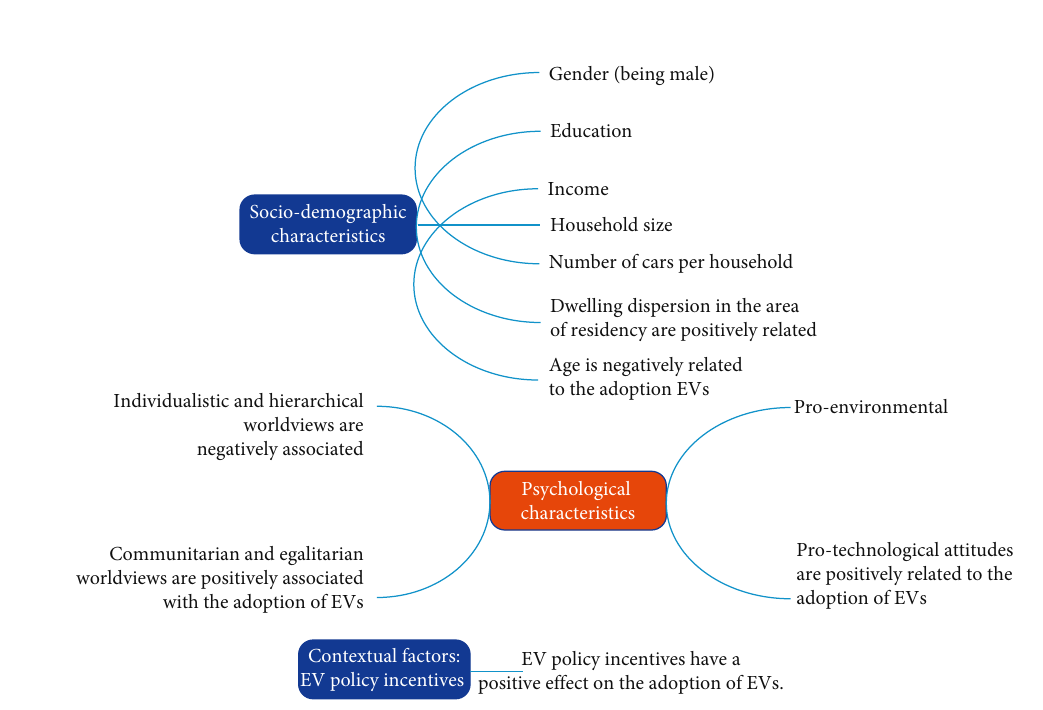
Figure 15: EV adoption hypothesis